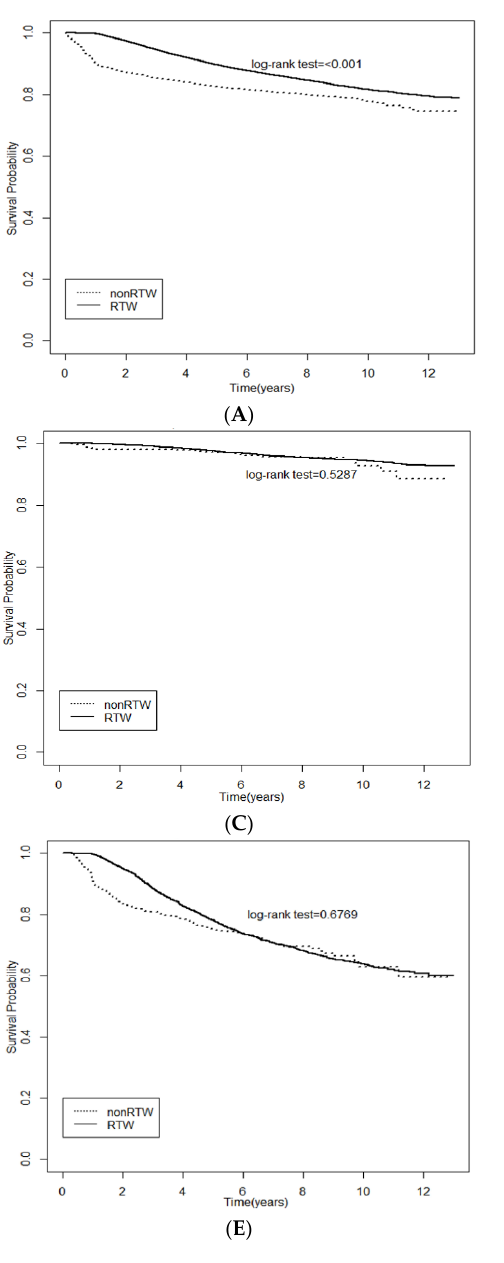
Figure 1. Kaplan-Meier (KM) curves showed survival probability of RTW for all ( A ) and stage 0–4 ( B – F ) breast cancer employers. ( A ) All stage; ( B ) Stage 0; ( C ) Stage 1; ( D ) Stage 2; ( E ) Stage 3; ( F ) Stage 4.